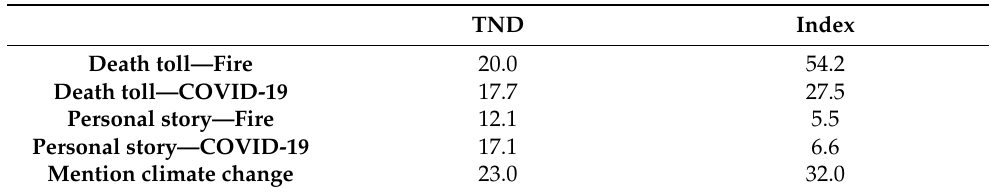
Table 2. Ratio of articles including death toll, personal story, and climate change (only in the case of bushfires) on the TND and Index news